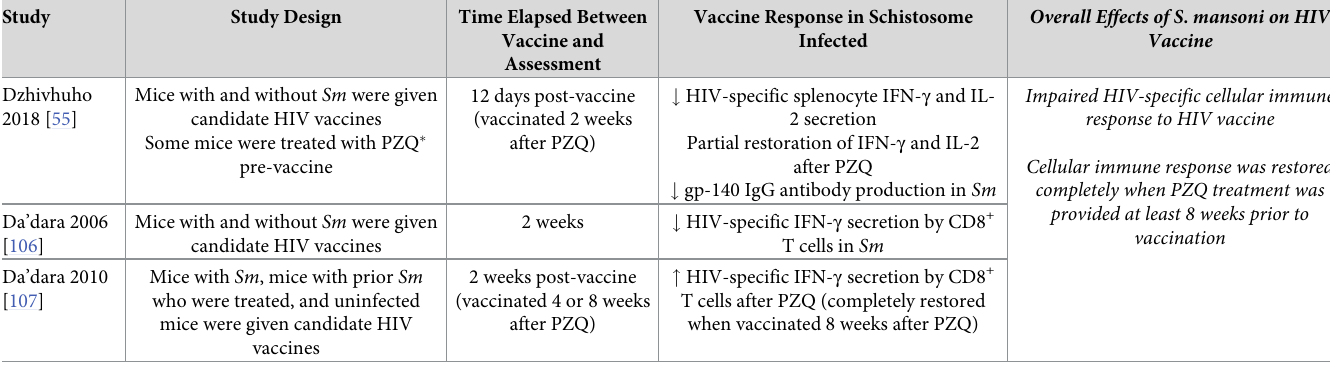
Table 6. Effects of Schistosoma mansoni Infection on Response to HIV Vaccine in Mice.